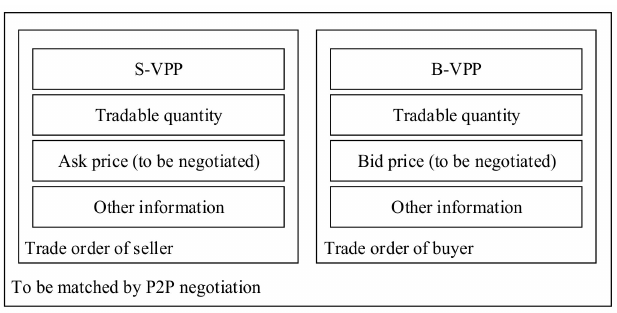
Figure 3. Format of trade order in P2P energy